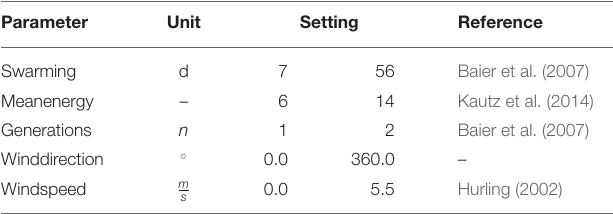
TABLE 3 | Parameter settings for IPS-SPREADS during the model calibration experiments with a reference for the chosen ranges. Parameter Unit Setting